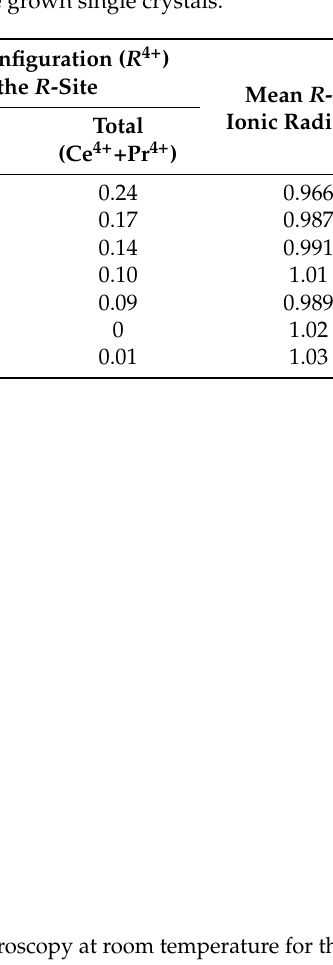
Table 2. Tetravalent electronic configuration ( R 4+ ) concentrations at the R -site, and mean R -site ionic radius considering the valence state ( R 3+ and R 4+ ) for the grown single crystals.